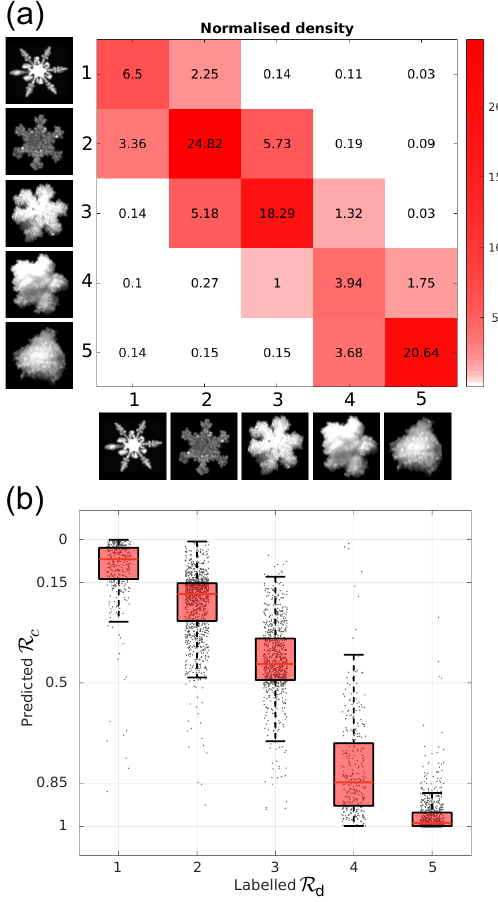
Figure 9. Illustration of the riming classification performance. (a) Confusion matrix of test data obtained by averaging 10 instances of 4-fold cross validation. Labeled riming degrees are on the hori- zontal axis and predicted riming degrees R d on the vertical axis. (b) Boxplots of predicted riming index R c as a function of the la- beled riming degree R d . The gray dots are the test data samples, horizontally spread around each value of R d to increase readabil- ity. The red lines are the medians, the boxes correspond to the in- terquartile range and the whiskers extend to 1.5 × the interquartile